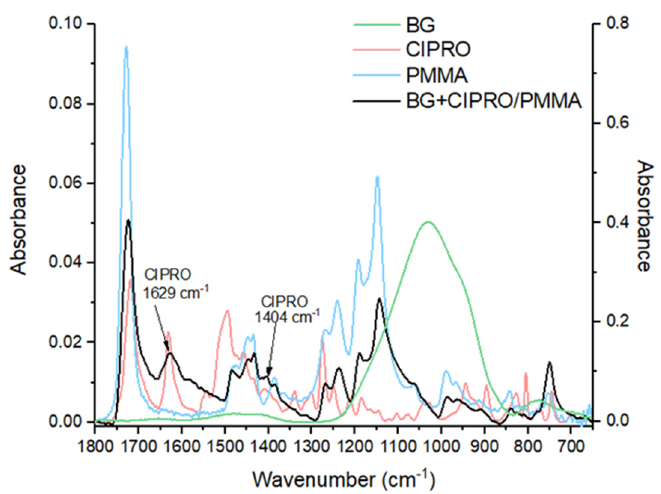
Figure 3 . FTIR spectra of BG+CIPRO/PMMA thin film deposited by MAPLE and of single components, namely PMMA, CIPRO, and BG. Note: OY axis (left)—absorbance of CIPRO, PMMA, and BG+CIPRO/PMMA thin film; OY axis (right)—absorbance of BG.